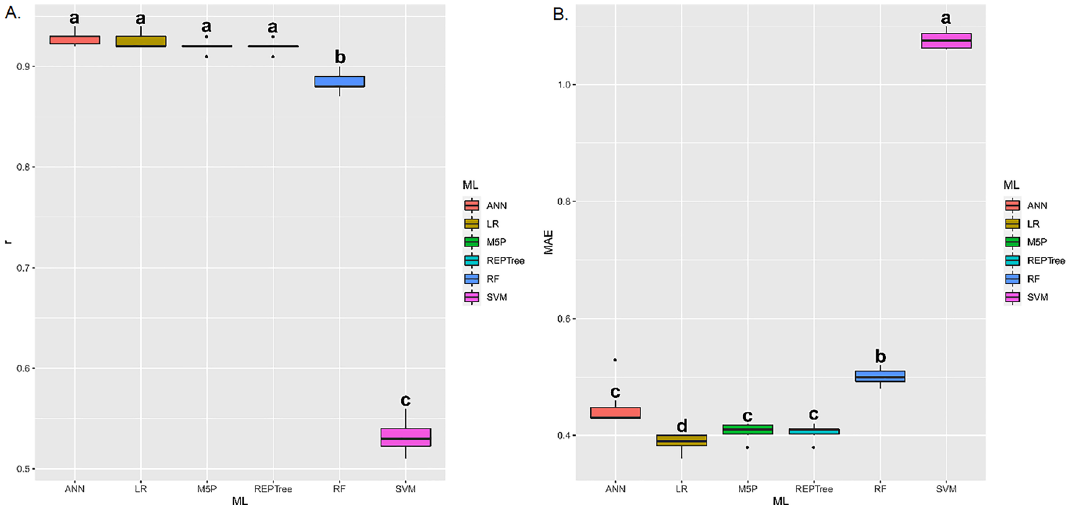
Figure 9. ( A ) Boxplot for Pearson correlation coefficient (r), and ( B ) mean absolute error (MAE) between observed and estimated values of electrical conductivity in corn grains by different machine learning models and inputs. Means followed by equal letters in the same column do not differ by the Scott–Knott test at 5% probability.